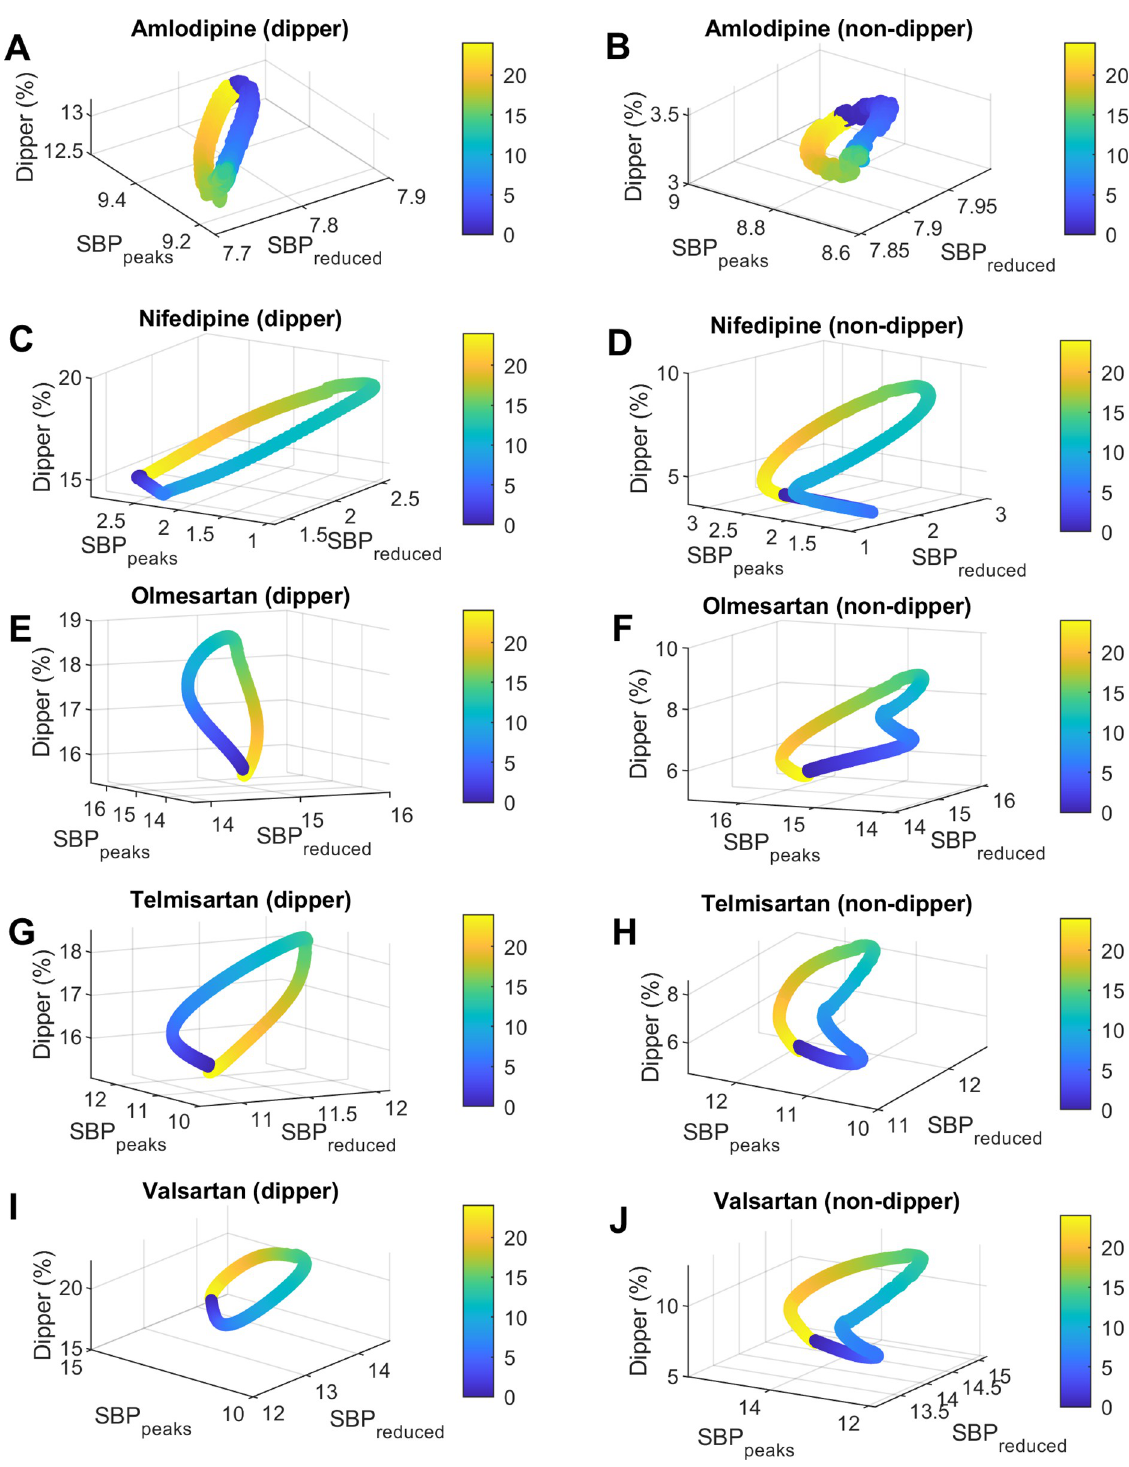
Fig 5. Relationship between dosing time and SBP dipper percentage, average SBP reduction ( SBP reduced ), and average SBP peaks reduction ( SBP peaks ) for amlodipine, nifedipine, telmisartan, olmesartan, and valsartan. The figures on the left show the results for dipper subjects and those on the right for non-dipper. Fig 5A and 5B, amlodipine; Fig 5C and 5D, nifedipine; Fig 5E and 5F, olmesartan; Fig 5G and 5H, telmisartan; Fig 5I and 5J, valsartan. Dosing time ( Ta ) is represented in colors from 0 to 24 hours after awakening (colorbar).